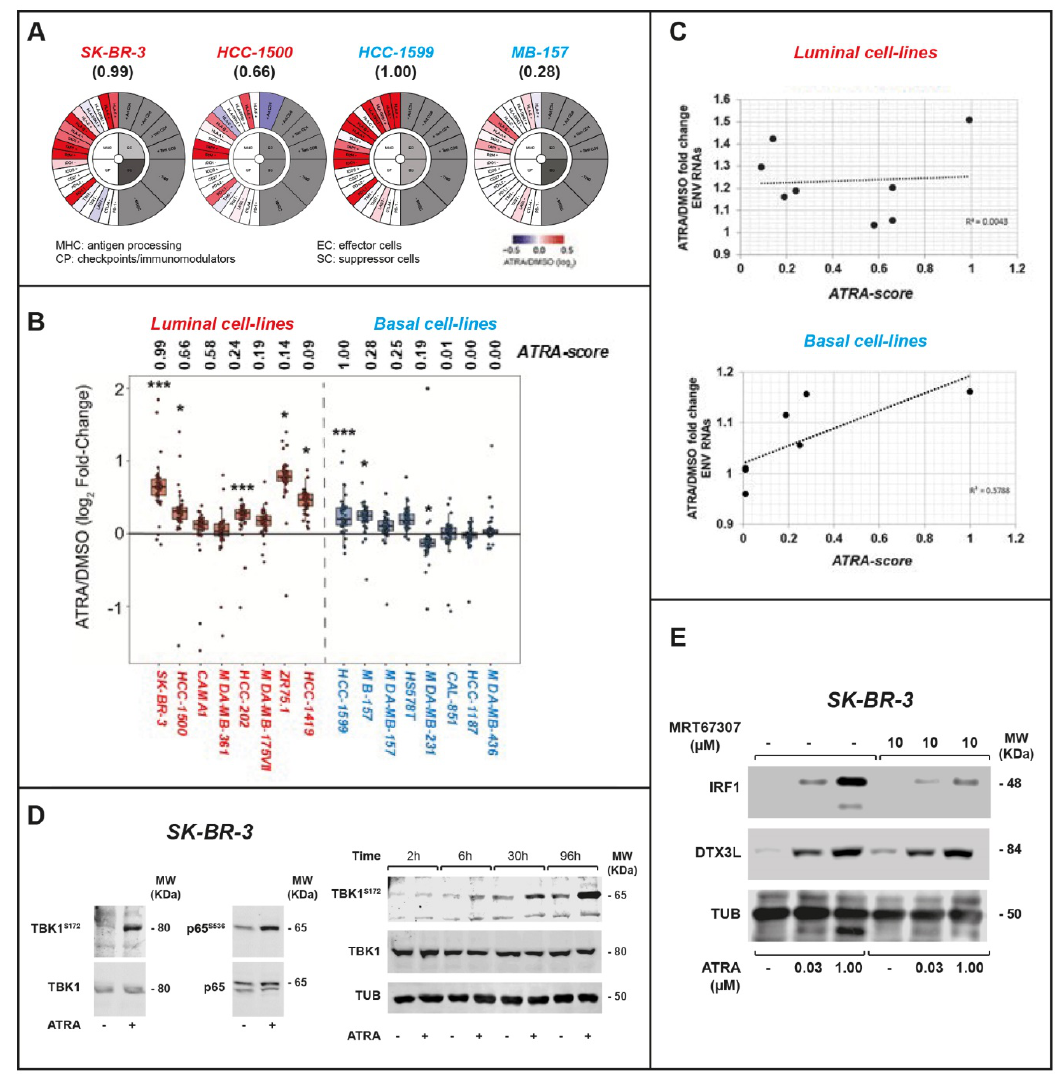
Figure 5. E ff ects of ATRA on the immunophenograms, endogenous retroviral elements and viral mimicry upstream regulators of breast cancer cell-lines. ( A ) The indicated cell-lines were treated with vehicle (DMSO) or ATRA (1 µ M) for 24 h. The circle plots show the effects exerted by ATRA on the immunophenograms derived from the RNA-seq data. The ATRA-score values are shown in parenthesis. ( B , C ) The indicated breast cancer cell-lines were exposed to vehicle (DMSO) or ATRA (1 µ M) for 24 h. ( B ) The box-plots show the effects exerted by ATRA on the expression of individual RNAs deriving from endogenous retroviruses ( ENV ). For each cell-line, the points represent the mean ( n = 3) ATRA/DMSO fold-change values of the single RNAs determined. Within the luminal and basal groups, cell-lines are positioned according to a decreasing ATRA-score from left to right, as indicated. * Significant ATRA-dependent up- or downregulation ( p -value < 0.1); *** Significant ATRA-dependent upregulation ( p -value < 0.001). ( C ) The diagrams illustrate the correlations between the effects exerted by ATRA on ENV -derived mRNAs and the ATRA-scores determined in luminal and basal cell-lines. ATRA/DMSO fold-change ENV RNAs = fold-change of the median expression values of the 42 classes of ENV RNAs determined in each cell-line following treatment with ATRA (1 µ M) or vehicle (DMSO) for 24 hours. The median fold-changes are expressed in linear values and were calculated from the logarithmic values shown in ( B ) and Supplementary Table S5. The R 2 values of the correlations are indicated. ( D ) Left: SK-BR-3 cells were treated with DMSO or ATRA (1 µ M) for 24 h. Cell extracts were subjected to Western blot analysis for TBK1, Serine/172 phosphorylated TBK1 (TBK1 S172 ), p65 and Serine /